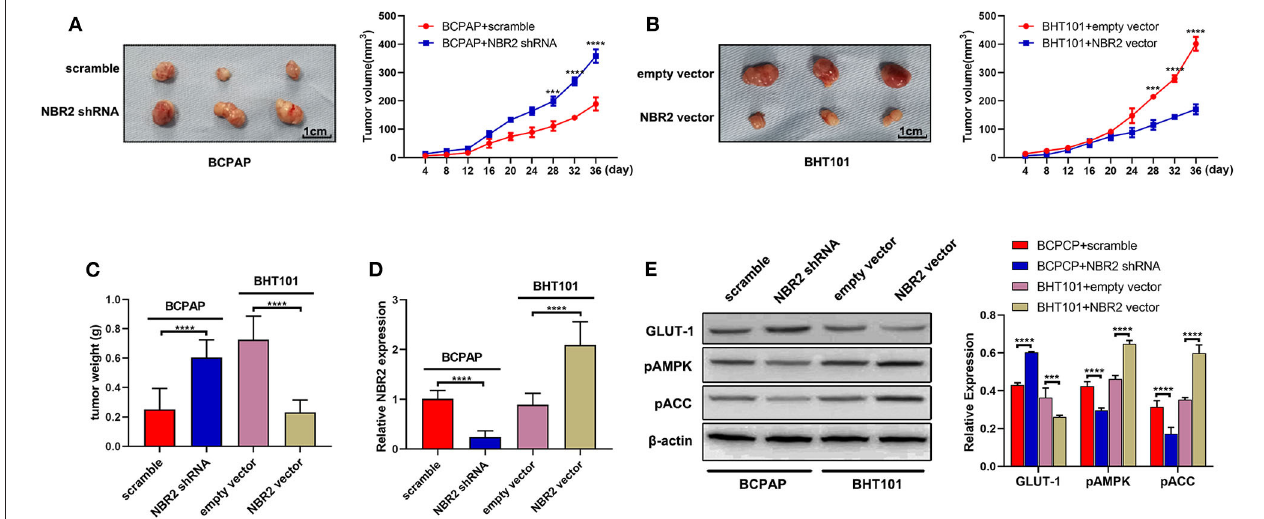
FIGURE 6 | NBR2 inhibits the growth of xenograft TC tumors in mice. (A,B) Representative images of tumor xenografts at the end of the experiment (left penal) and the dynamic growth of xenograft tumors (right penal). (C) The tumor weights. (D) Quantitative RT-PCR analysis of NBR2 expression in tumor tissues. (E) Western blot analysis of the levels of GLUT-1 expression, AMPK, and ACC phosphorylation in tumor tissues. Data are representative images or expressed as the mean ± SD of each group of tumors ( n = 3 per group). *** P < 0.005; **** P <